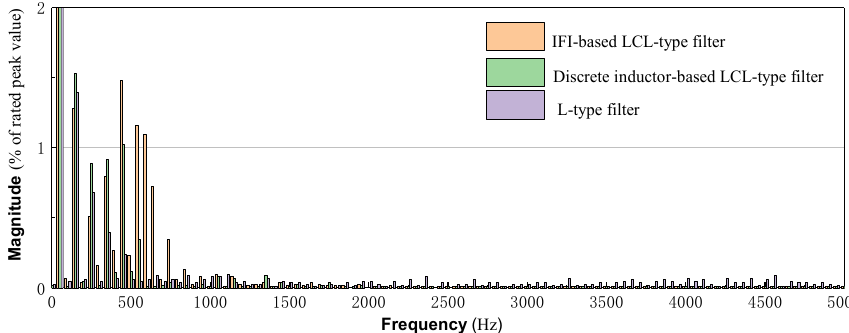
Figure 13. Comparison of the simulated FFT analysis result of i g .